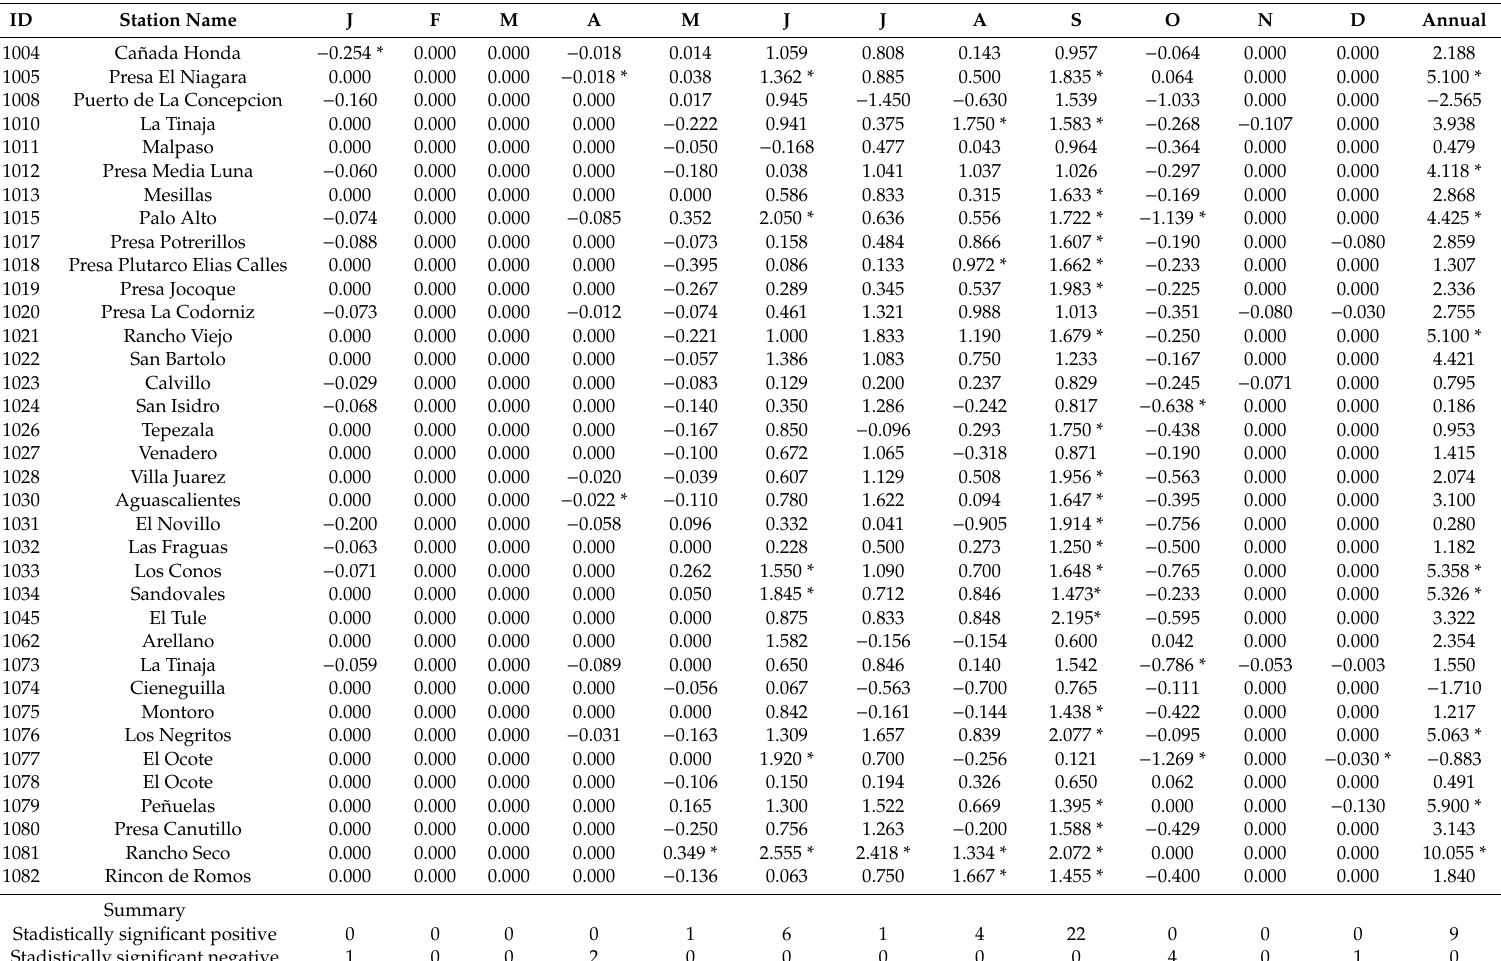
Table 2. Trend of monthly and annual precipitation in Aguascalientes